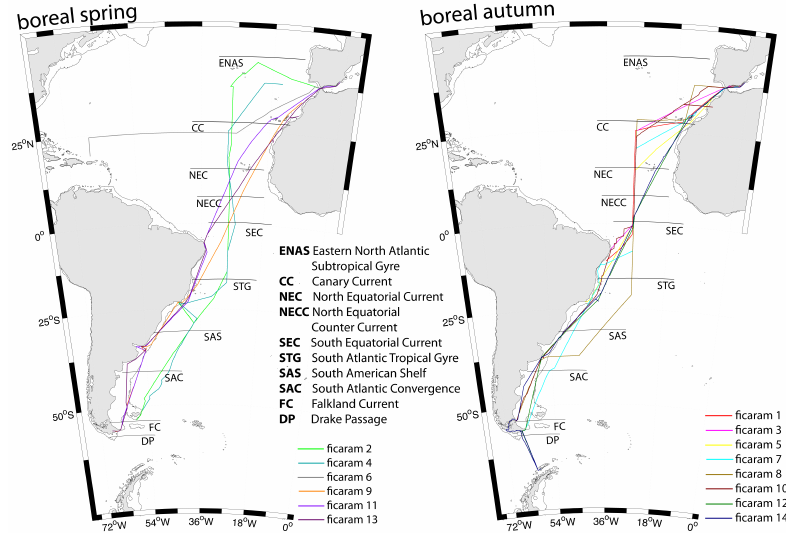
Fig. 1. Map showing the ship tracks and biogeochemical provinces selected for the FICARAM cruises. Left panel gives boreal spring tracks and right panel the boreal autumn